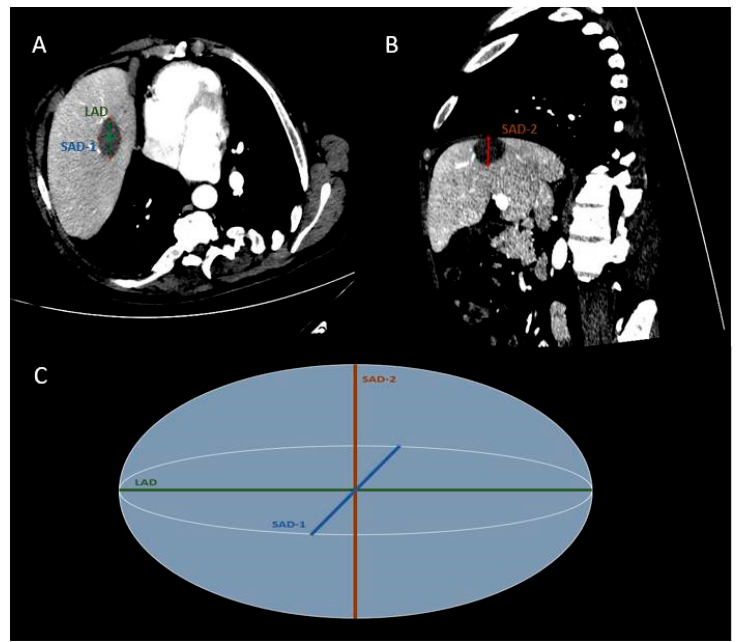
Figure 4. CT scan of a 54-year-old man showing a colorectal cancer metastasis in liver segment VIII post microwave ablation (MWA). Enhanced transverse ( A ) and parasagittal ( B ) CT images. Simplified scheme of MWA zone ( C ). The short-axis diameters (SAD-1,-2) are orientated perpendicular to the long-axis diameter (LAD).